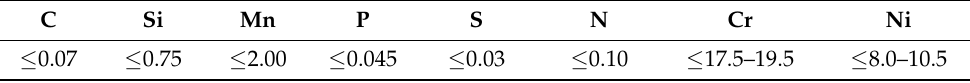
Figure 1. Type 304 stainless steel sample in a circular shape.